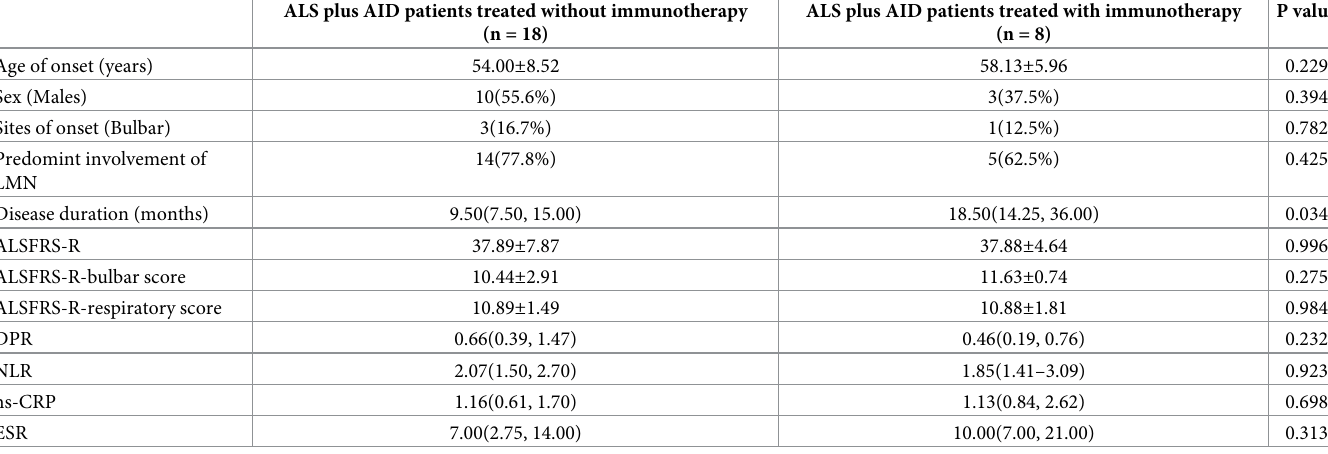
Table 4. Clinical characteristics and serum inflammatory biomarkers of ALS patients with AID grouped by the history of immunotherapy. ALS plus AID patients treated without immunotherapy (n =